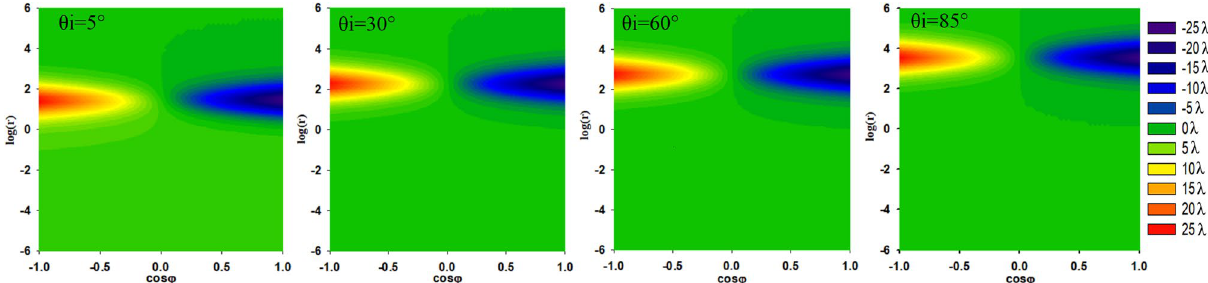
Figure 2. Dependence of transverse shifts on cos ϕ and log(r) at different incident angles, where ω 0 = 50λ.